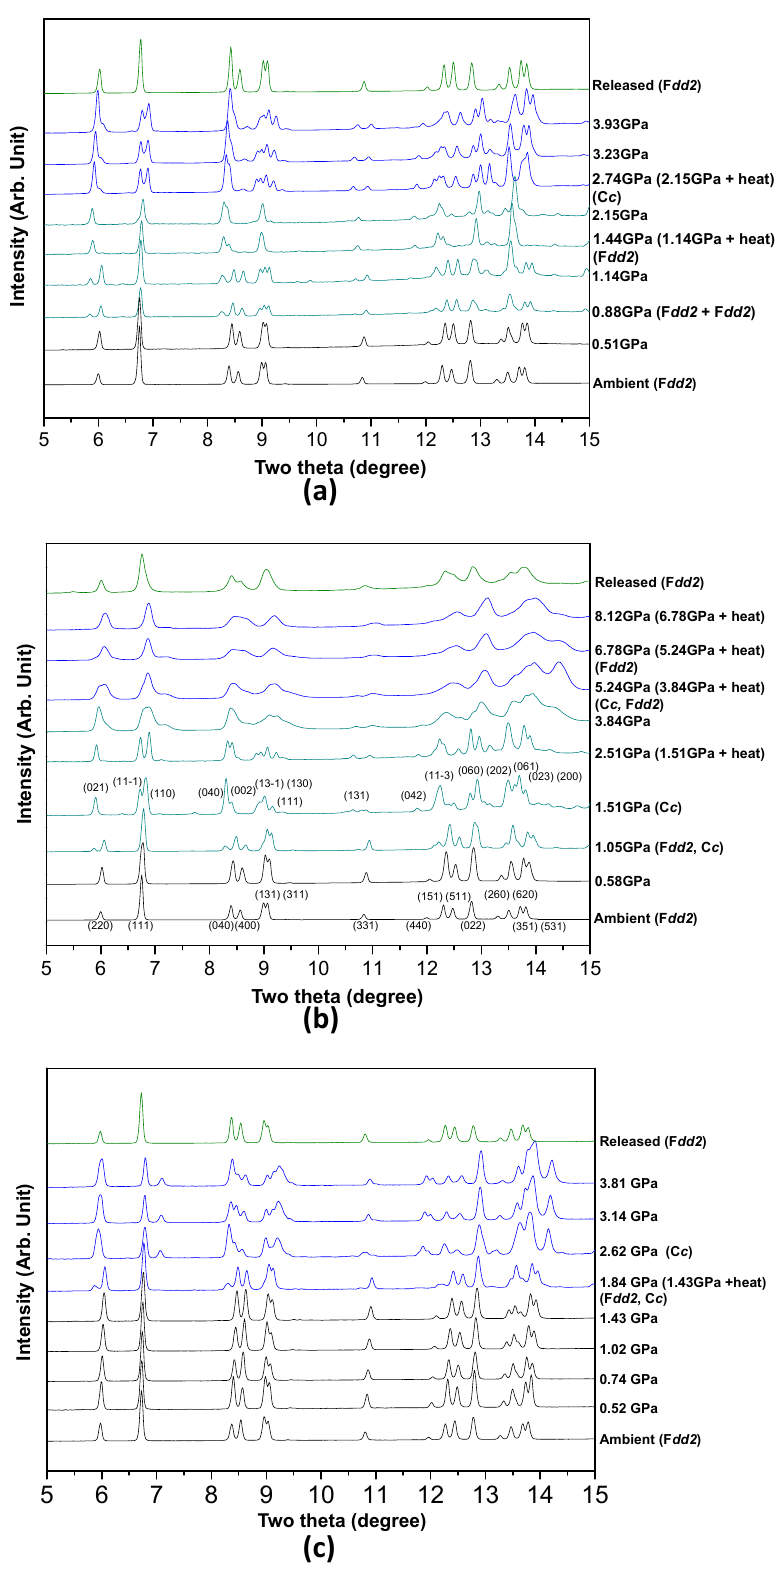
Figure 1. Pressure- and temperature-induced changes of the synchrotron X-ray powder di ff raction patterns of Ag-NAT in presence of ( a ) N 2 , ( b ) O 2 and ( c ) CH 4 . Wavelength of X-ray w 0.6888(1) Å and 0.6927(1) Å in a case of N 2 (and O 2 ) run and CH 4 run,